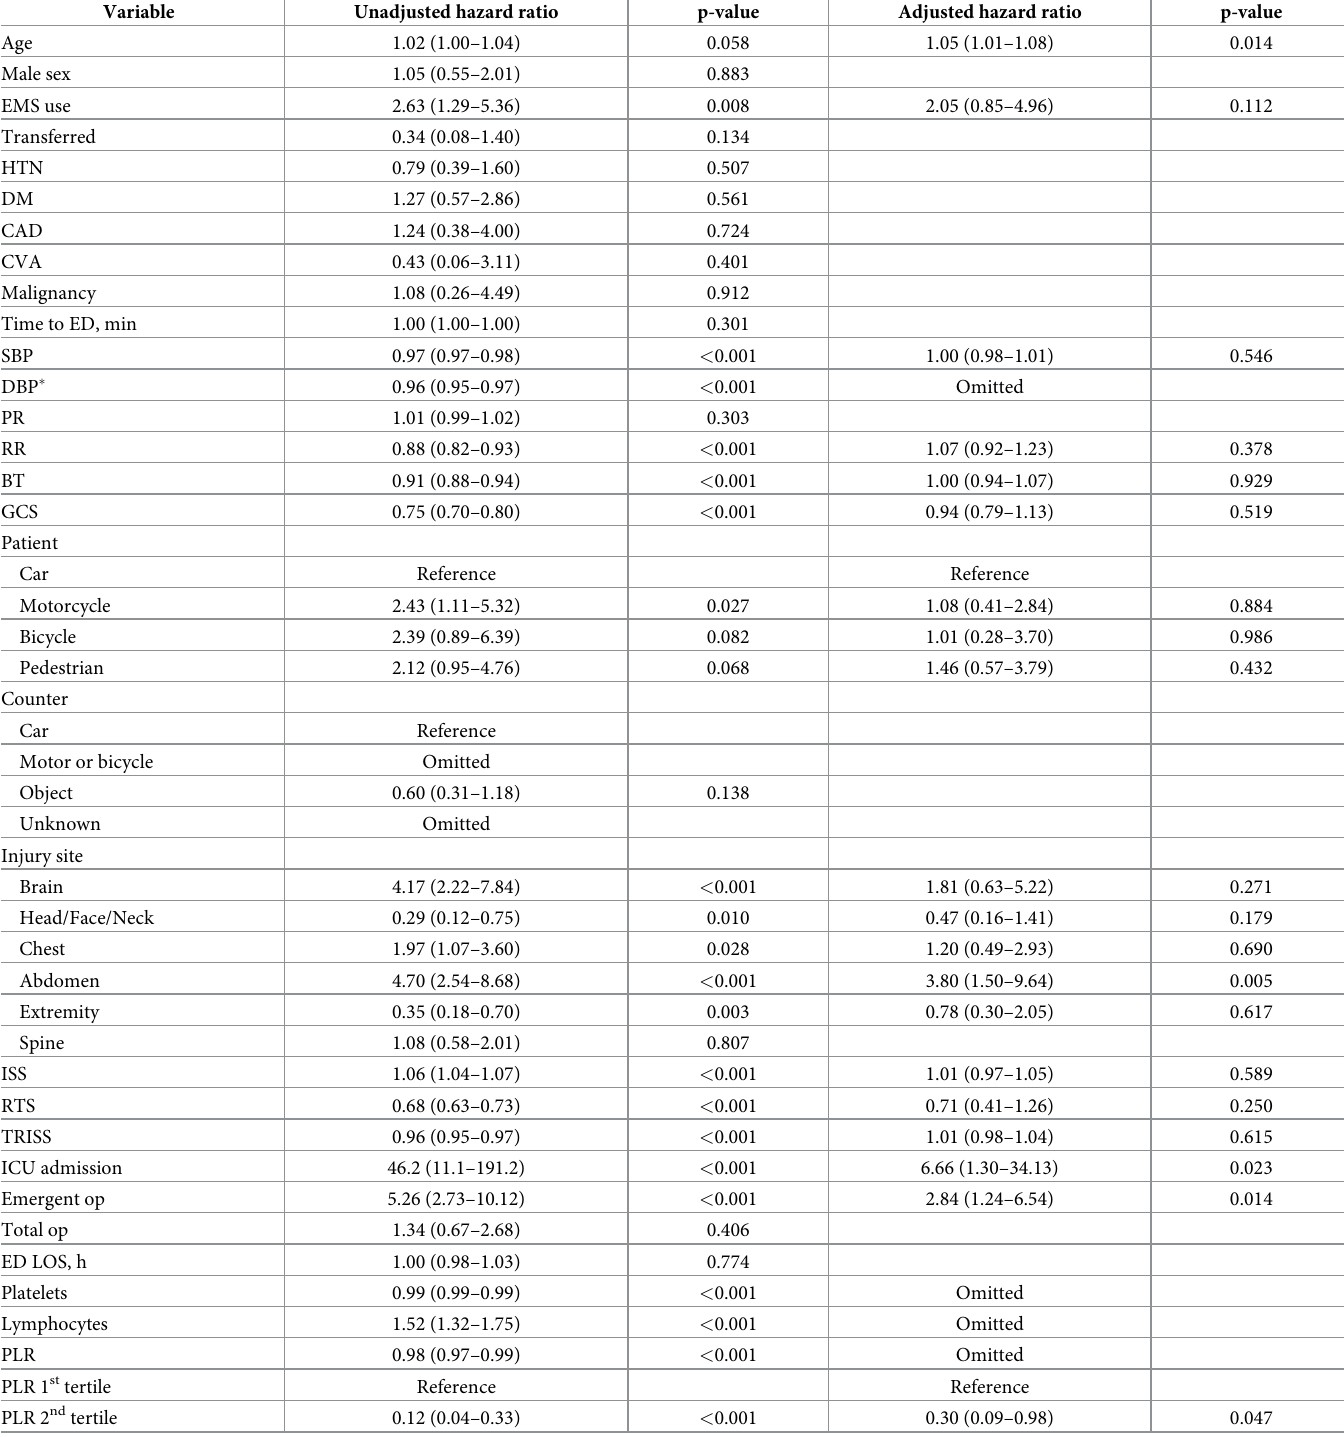
Table 2. Cox hazard regression analysis for the total number of